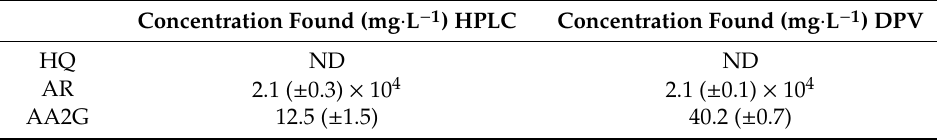
Table 2. The content of hydroquinone, arbutin, and ascorbyl glucoside in the whitening lotion ( n = 3).